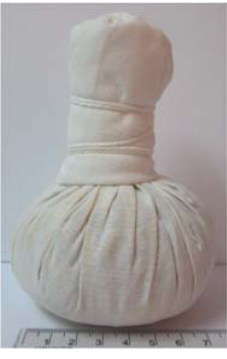
Figure 1. Herbal ball.